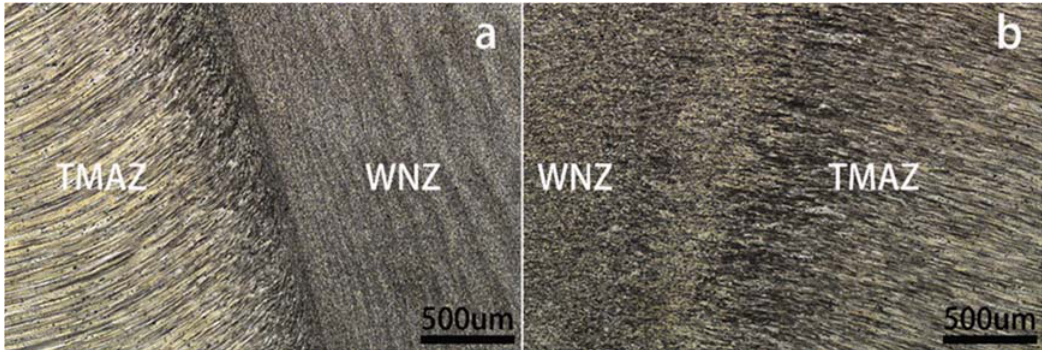
Figure 4. Microstructures of the weld nugget and thermo ‐ mechanically affected zones in FSW joint of 7A52 alloy: ( a ) advancing side, ( b ) retreating side.